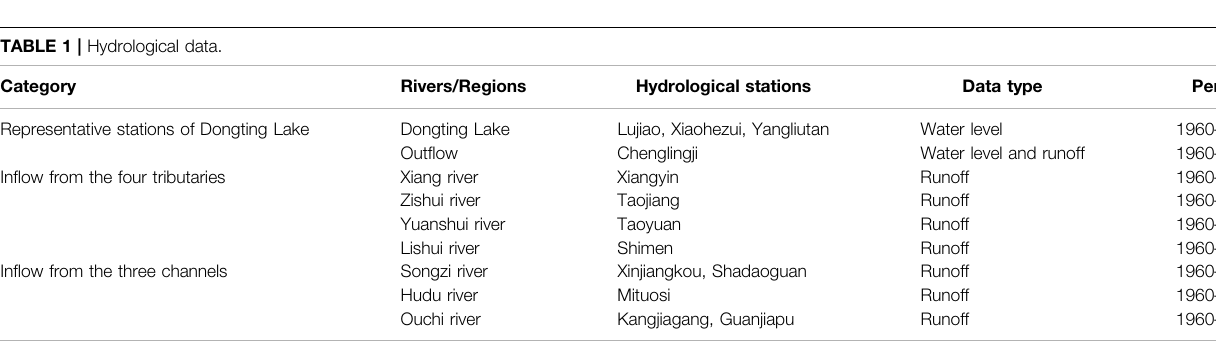
TABLE 1 | Hydrological